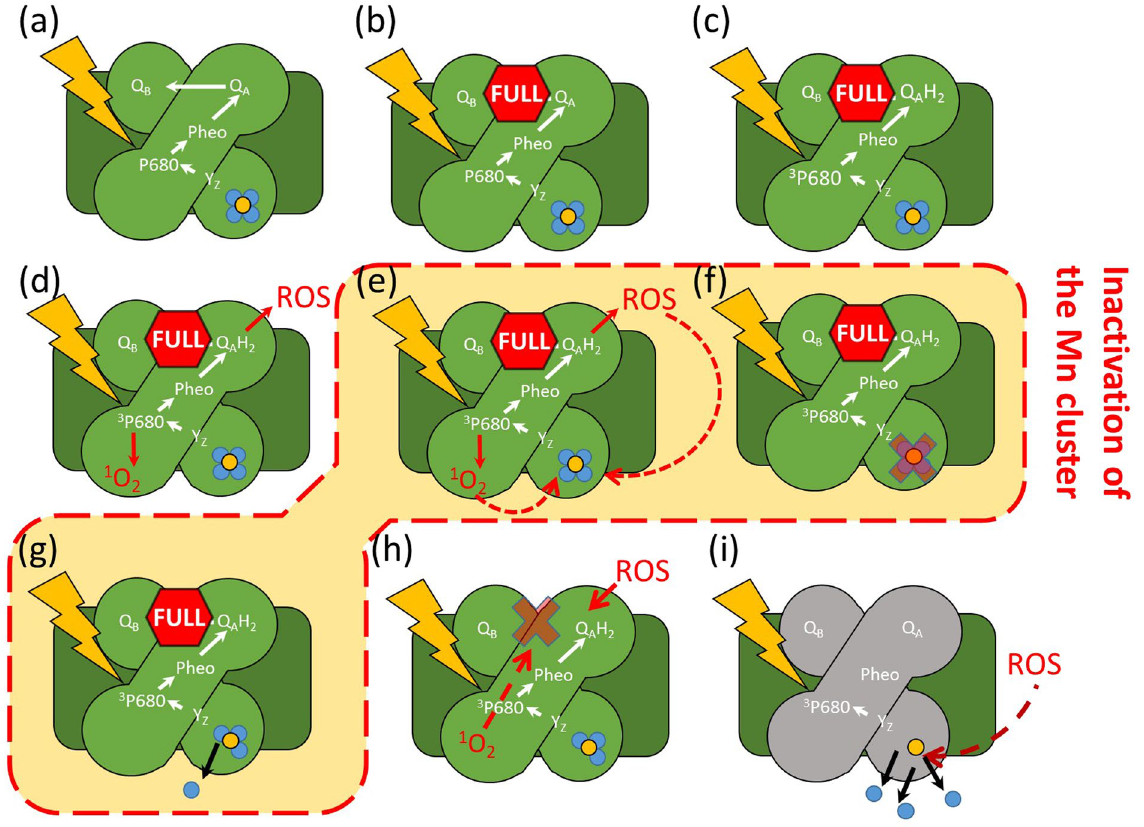
Figure 4. Proposed mechanism of PSII photodamage in high light. ( a ) Active PSII absorbs photons. ( b ) The pool of acceptors is fully reduced. ( c ) Repetitive turnover P680 + Q A − induces formation of P680 triplet or side reactions as described by Vass 8 . ( d ) Accumulation of ROS occurs at several parts of PSII and they diffuse to several sites. ( e ) Inactivation of the Mn 4 CaO 5 cluster by ROS. ( f ) Once the Mn 4 CaO 5 cluster is inactive, the Mn 2 + ion is released. ( g ) In parallel to inactivation to the Mn 4 CaO 5 cluster, ROS may deactivate the